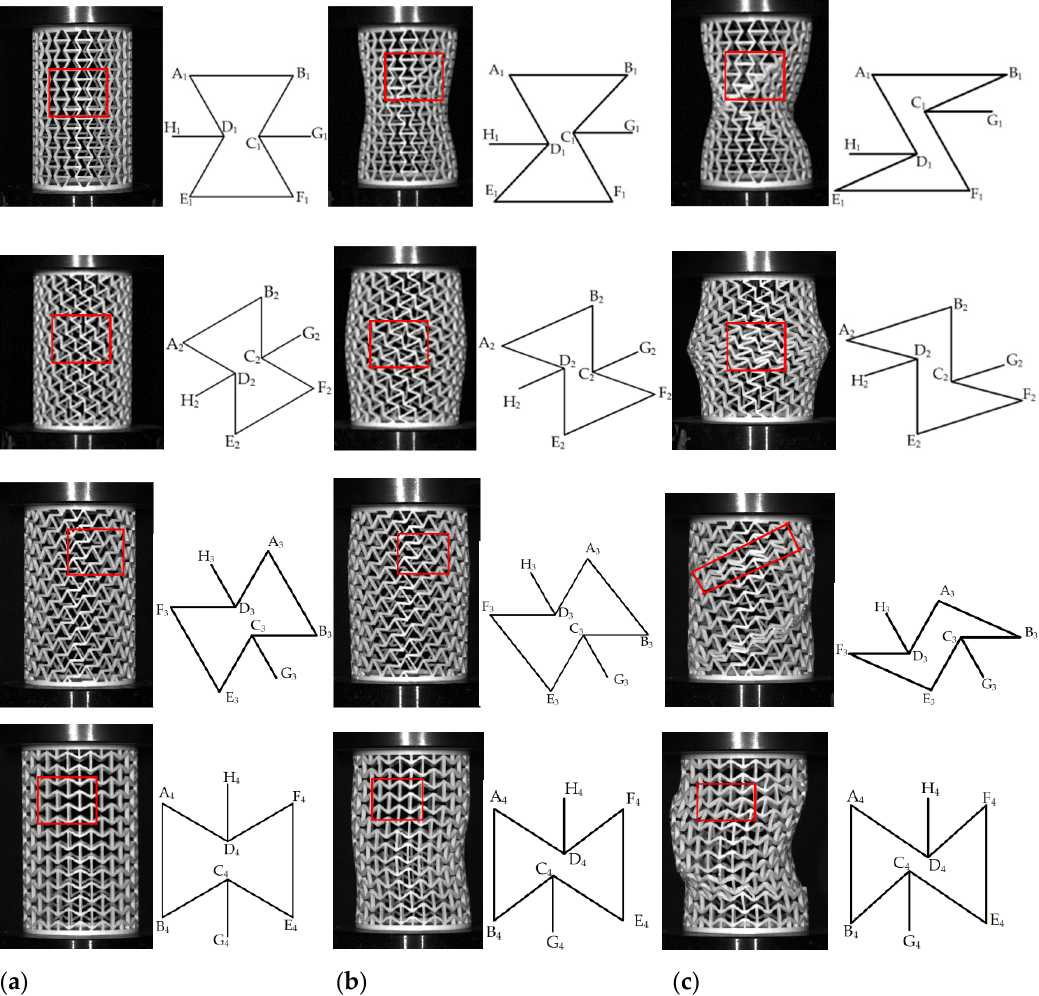
Figure 13. The deformation modes of single-layer RHCSs: ( a ) the initial configuration; ( b ) the deformation modes in the elastic stage; ( c ) the deformation modes in the plateau stage.